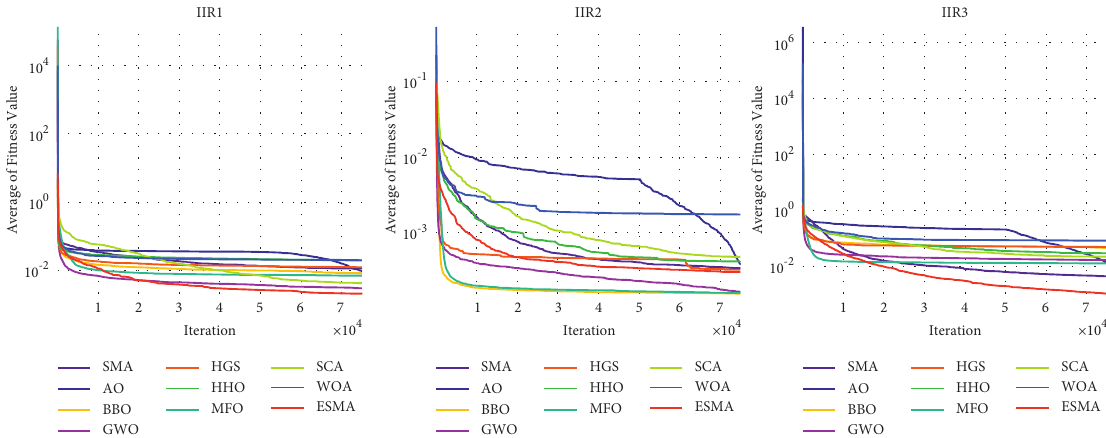
Figure 6: Convergence curves of ESMA and compared algorithms on 3 IIR